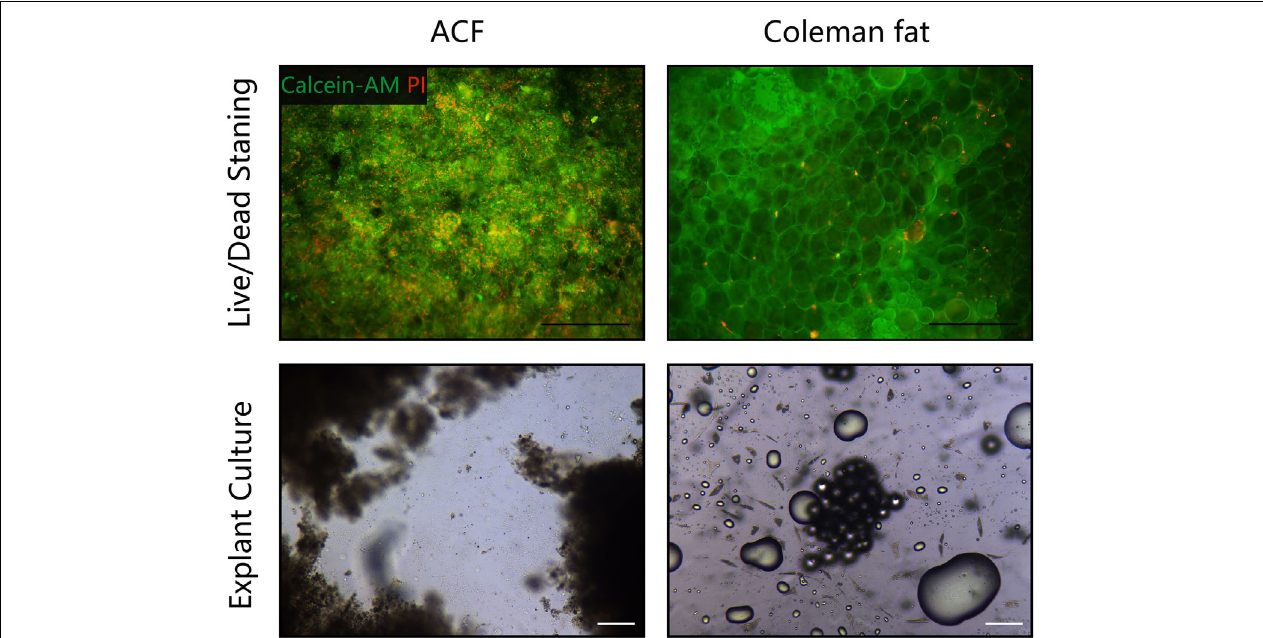
FIGURE 5 | Cell viability assessment of ACF and Coleman fat. (Above) Live/dead staining of ACF and Coleman fat. Scale bar = 100 µ m. Massive dead cells (red) were observed in the ACF, while only a few dead cells (red) were observed in Coleman fat. (Below) Explant culture assays of ACF and Coleman fat. No outgrown cells were observed in the ACF explant culture assays; nevertheless, many fibroblastic-like cells were detected outgrown from Coleman fat explants. Scale bar = 200 µ m. The experiment was independently repeated three times.